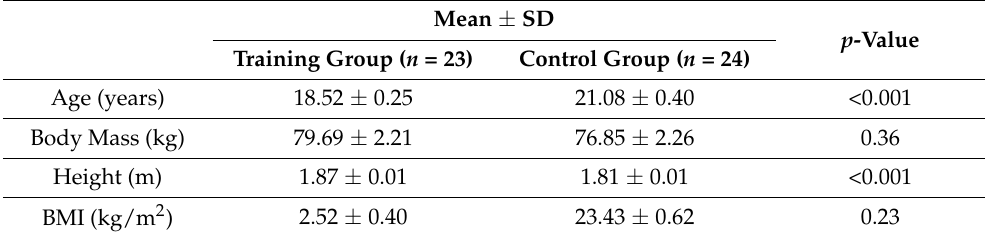
Table 1. Anthropometric measurements.